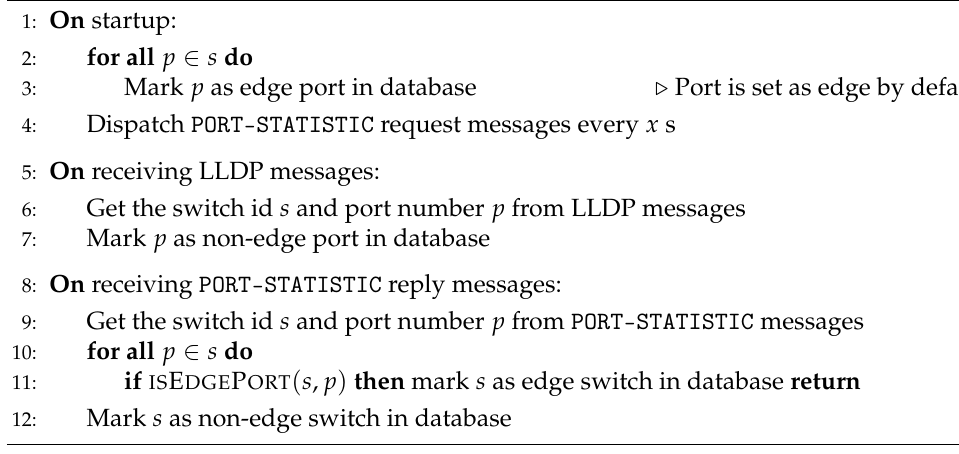
Algorithm 1 The Switch Tracker module’s